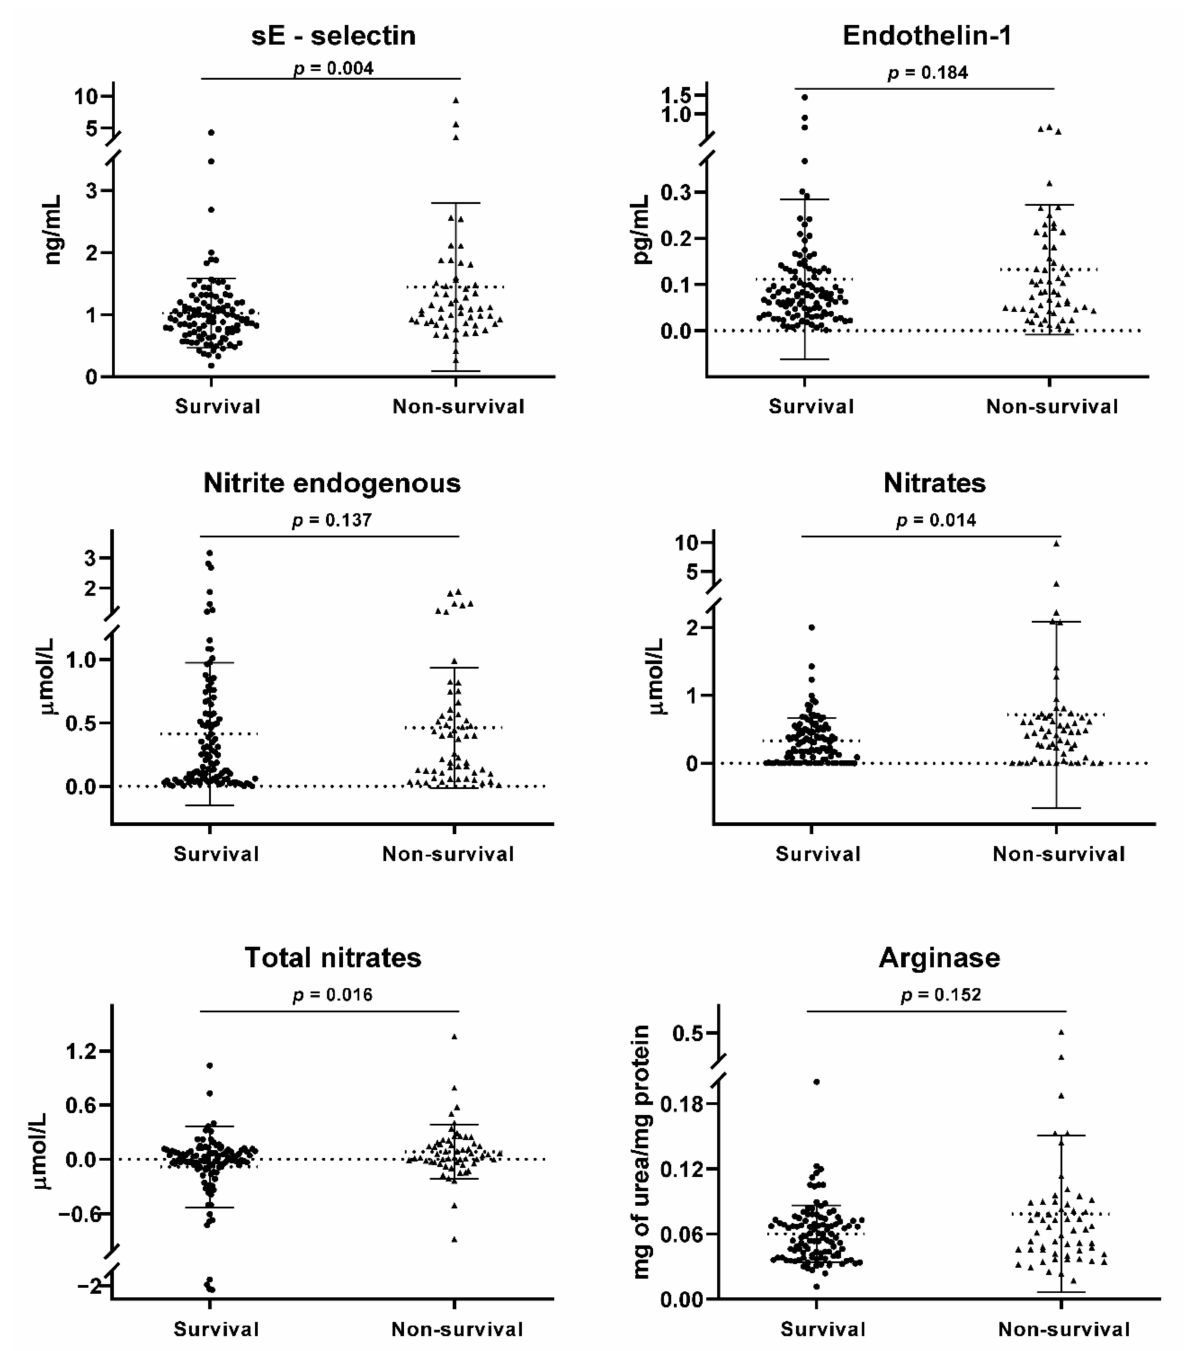
Figure 1. Endothelial dysfunction biomarkers. A comparison of medians between the study groups was performed using the Mann-Whitney test. A p < 0.05 was considered statistically